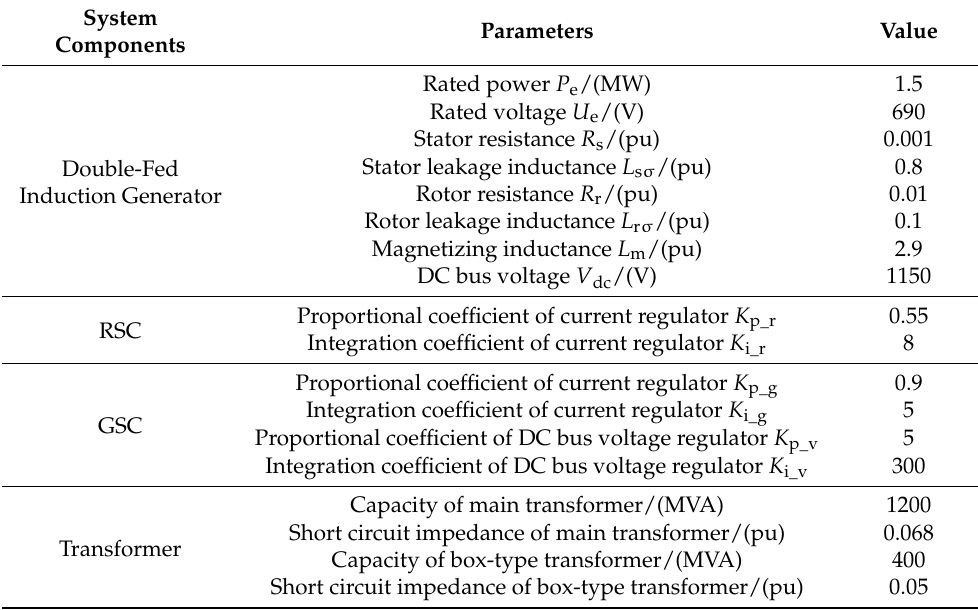
Table 1. Control parameters of wind power